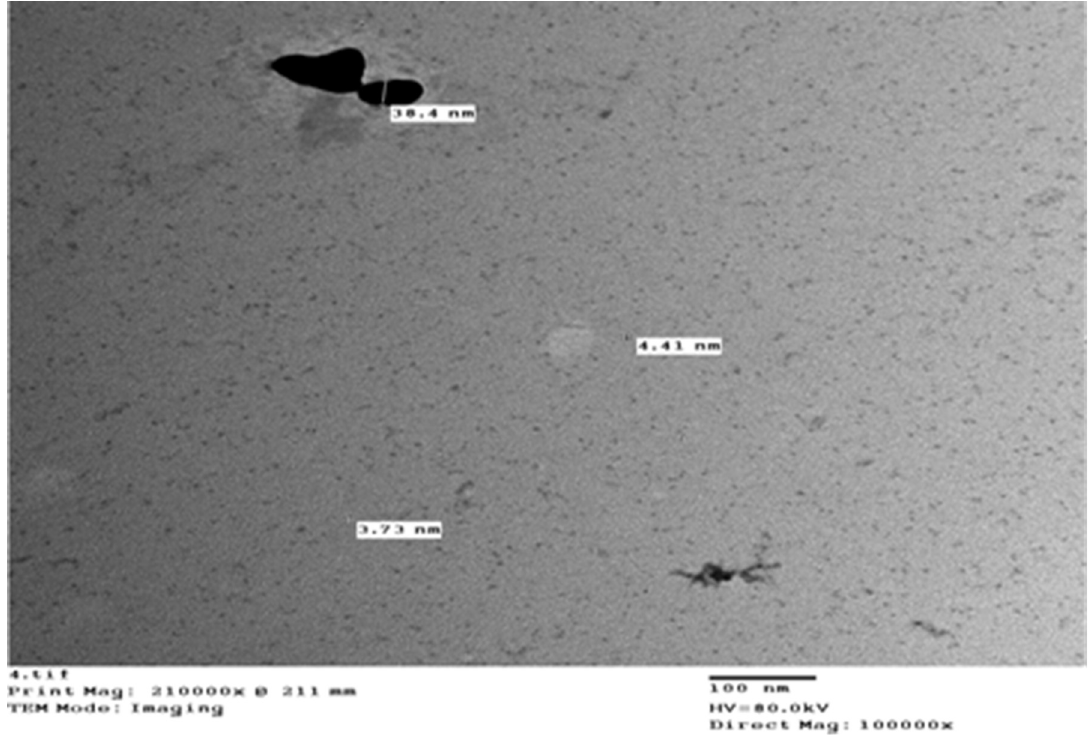
Fig 2. Nano-sulphur.